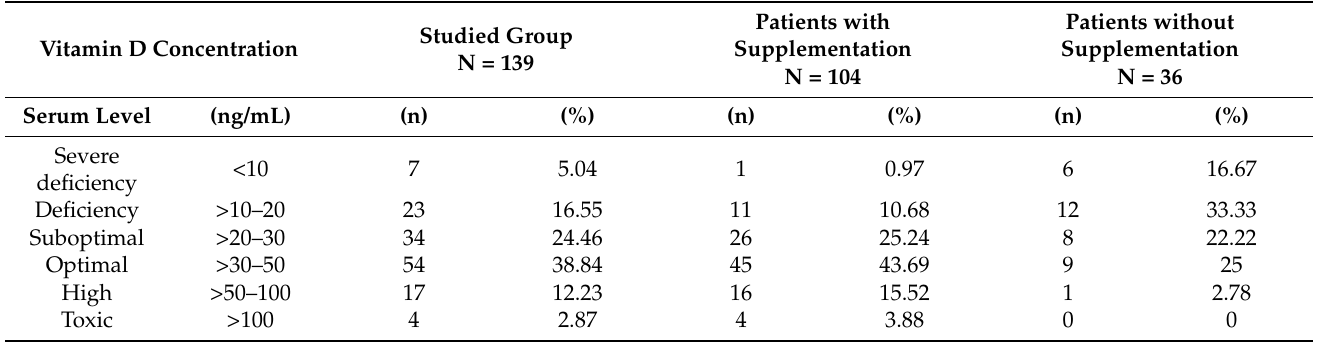
Table 2. Vitamin D serum levels among studied group at the